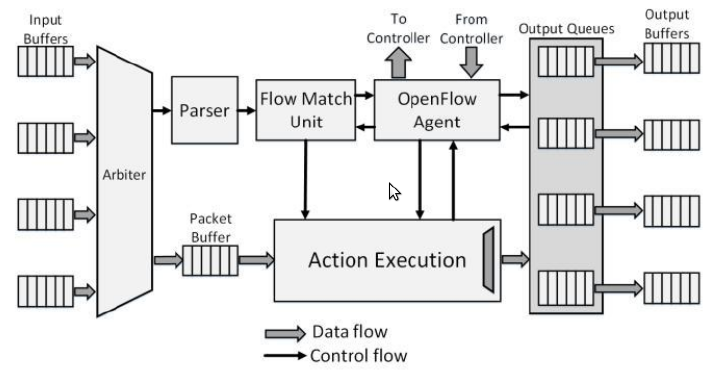
Figure 1. The architecture of an SDNswitch